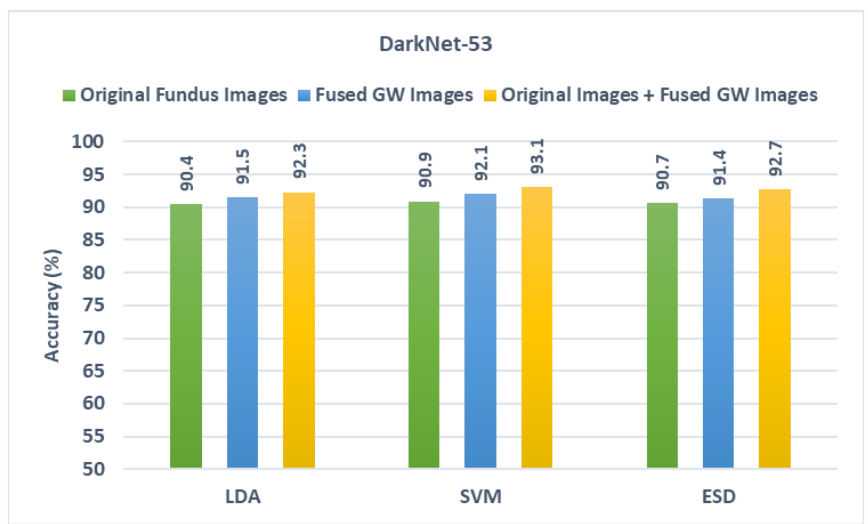
Figure 8. Diagnostic accuracy of the three classifiers trained with spatial features extracted from DarkNet-53 learned using the original fundus images compared the fused DWT features obtained by CNNs learned with GW images and the combination of the two.